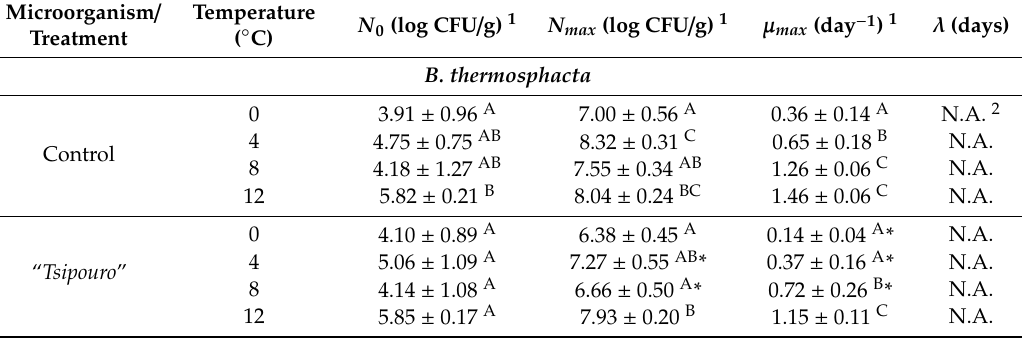
Table 1. Kinetic parameters and statistics of B. thermosphacta and LAB estimated from the primary model of Baranyi and Roberts on ground beef (500 g) packaged with absorbent pads supplemented with 50 mL of “ tsipouro ” (40 mL under the ground beef piece and 10 mL under the labelling, facing the headspace) and stored at 0, 4, 8, and 12 ◦ C under 80% O 2 : 20% CO 2 . Untreated samples served as